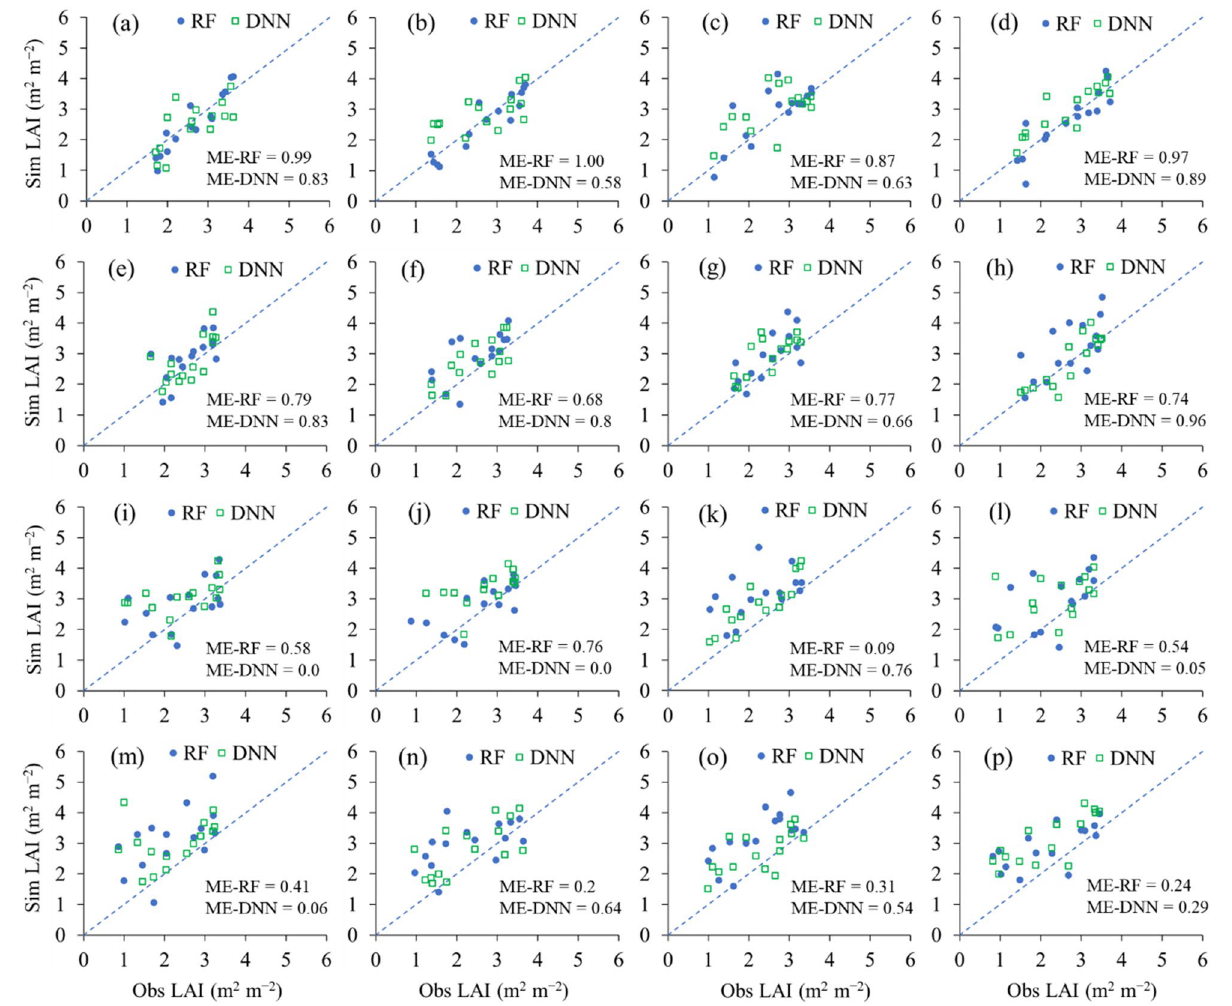
Figure 2. Simulated (Sim) versus observed (Obs) LAI of paddy rice using the RF and DNN regressors for ( a – d ) Cheorwon, ( e – h ) Paju, ( i – l ) Gimje, South Korea, and ( m – p ) Pyeongyang, North Korea in ( a , e , i , and m ) 2014, ( b , f , j , and n ) 2015, ( c , g , k , and o ) 2016, and ( d , h , l , and p ) 2017. ME-RF and ME-DNN represent the model efficiency of RF and the model efficiency of